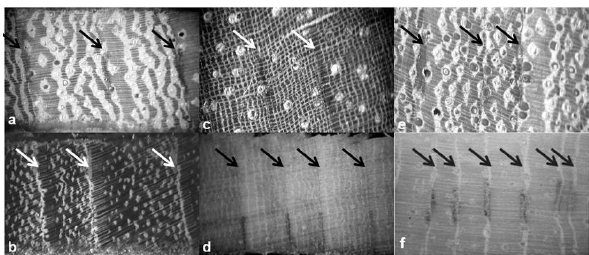
Fig. 2. Examples of distinct tree rings. The classification of wood anatomy of the tree rings is described following Worbes (2002). (a, b) Parenchyma bands limiting ring boundaries and vessel size/distribution variation from earlywood to latewood; (c, d) al- ternating fiber and parenchyma bands, large in the earlywood and narrow in the latewood; (e, f) marginal parenchyma bands limiting the tree rings. Arrows indicate the boundary of the tree